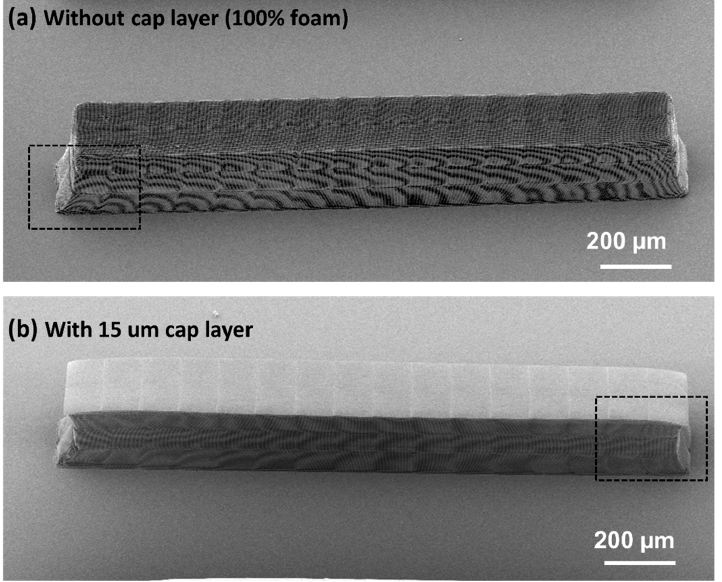
Figure 8. SEM images of 2 × 0.25 × 0.3 mm 3 foam rod with x, y, z cell dimensions of 6.2 × 6.2 × 1 μ m 3